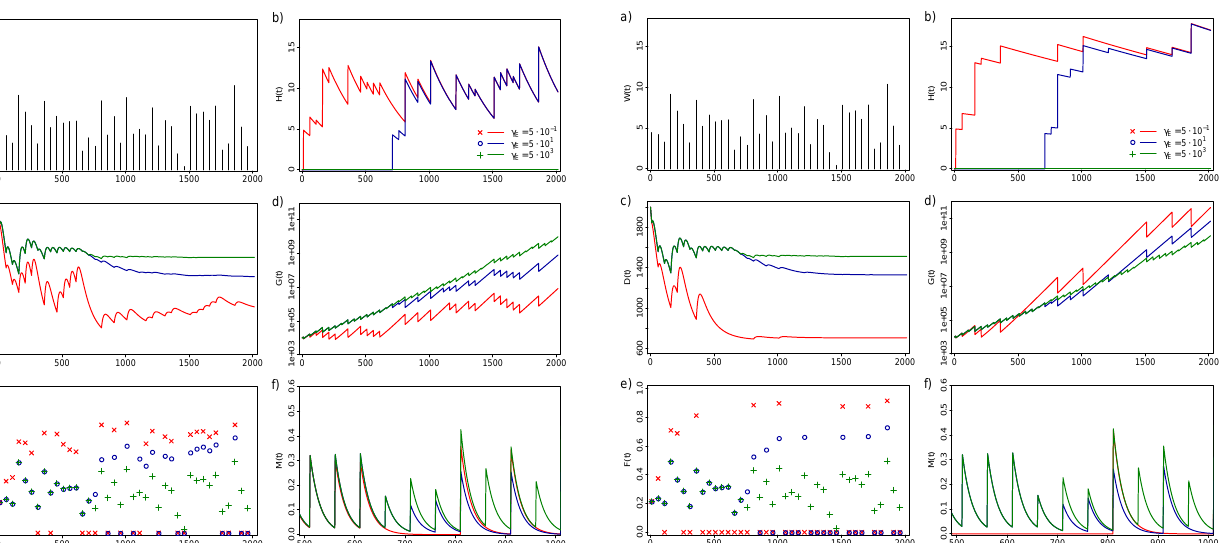
high-cost scenario. Afterwards, because of the presence of levees, some events are avoided, while others enhanced. The enhancement is due to: (i) WetTown resettling closer to the river, and (ii) high water levels exacerbated by the presence of levees. The exacerbation of high water levels (in turn) also causes differences in the dynamics of the protection levels (Fig. 4b), which is visible by comparing the moderate- and high-cost scenarios between years 700 and 1000. In this pe- riod, in the moderate-scenario the community starts building levees, which are lower than in the low-cost scenarios be- cause the exacerbation of high water levels has not yet taken place. By looking at peoples’ awareness of risk in the transition period around year 700 (Fig. 4f), one notices that the pres- ence of levees reduces the awareness of flooding because of two reasons: (i) the reduction in the frequency of flooding; and (ii) the false sense of security due to the construction